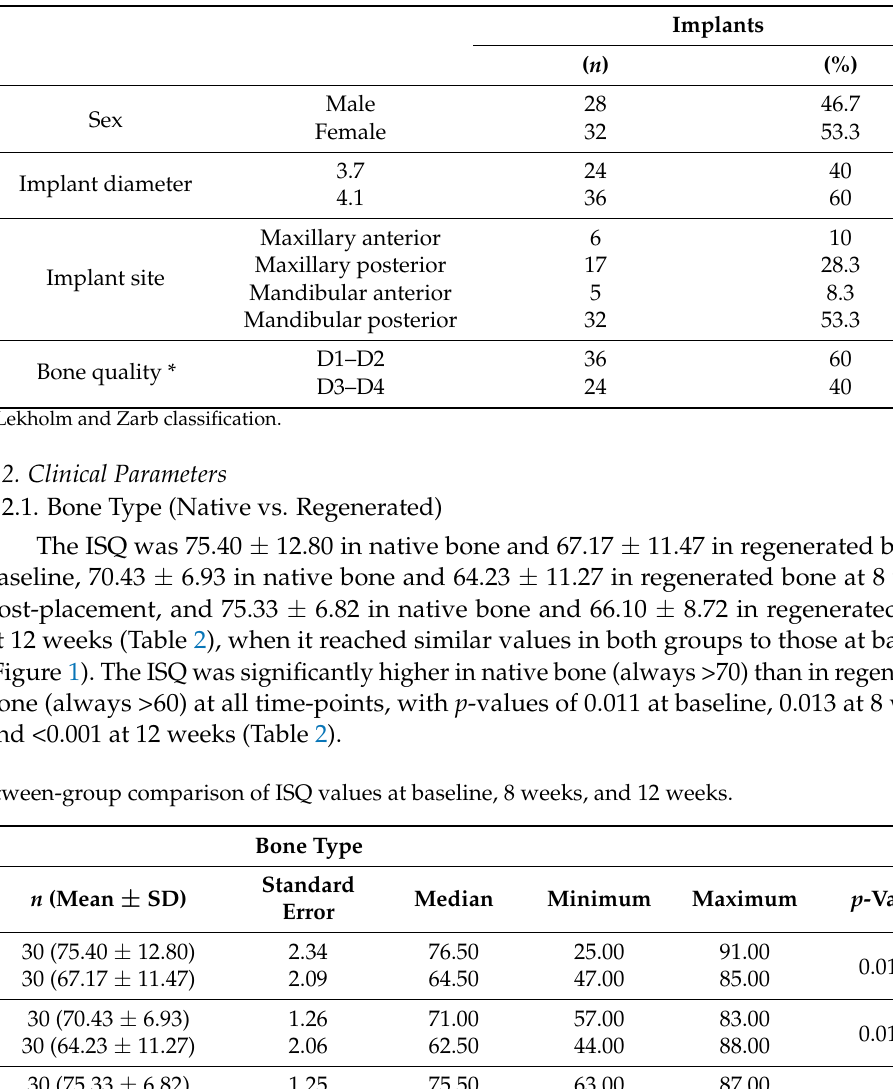
Table 1. Data on patient sex, implant diameter, implant distribution, and bone quality.